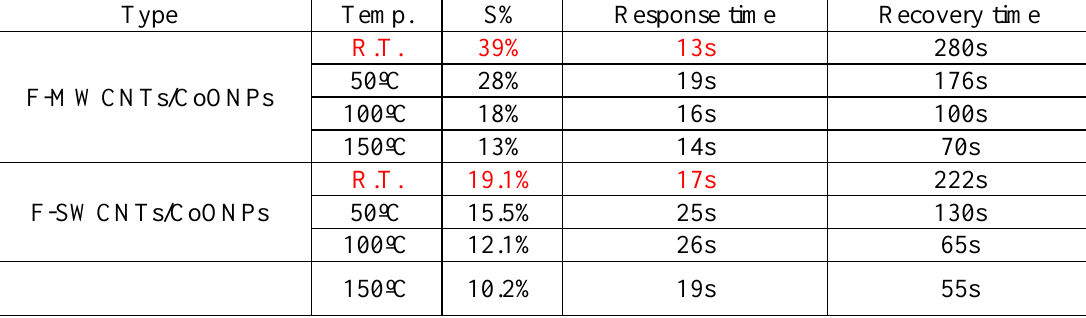
Table 3: The sensitivity (S), response time, and recovery time of F-MWCNTs/CoO NPs and F-SWCNTs/CoO NPs when exposed to NO 2